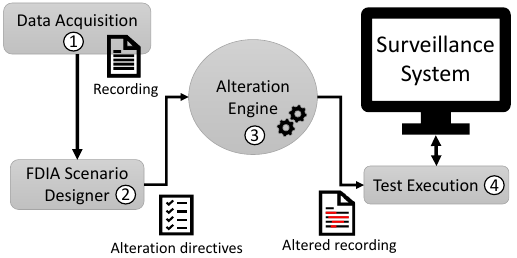
Figure 2. FDI-T Framework